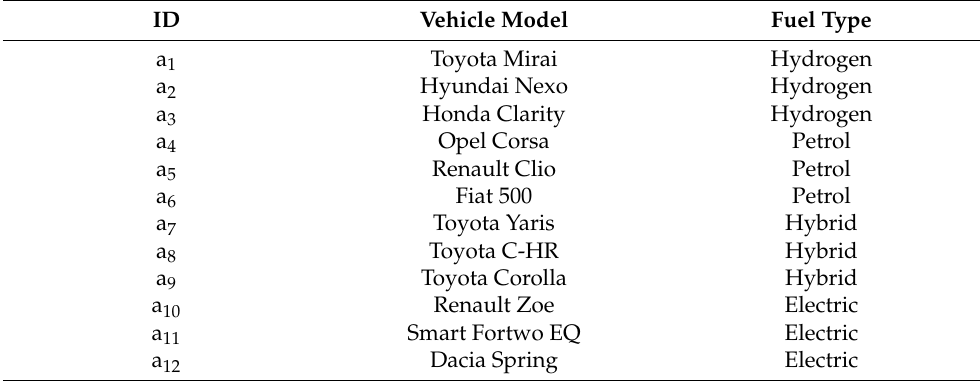
Table 2. Cars included in the analysis that can be used in car-sharing systems.